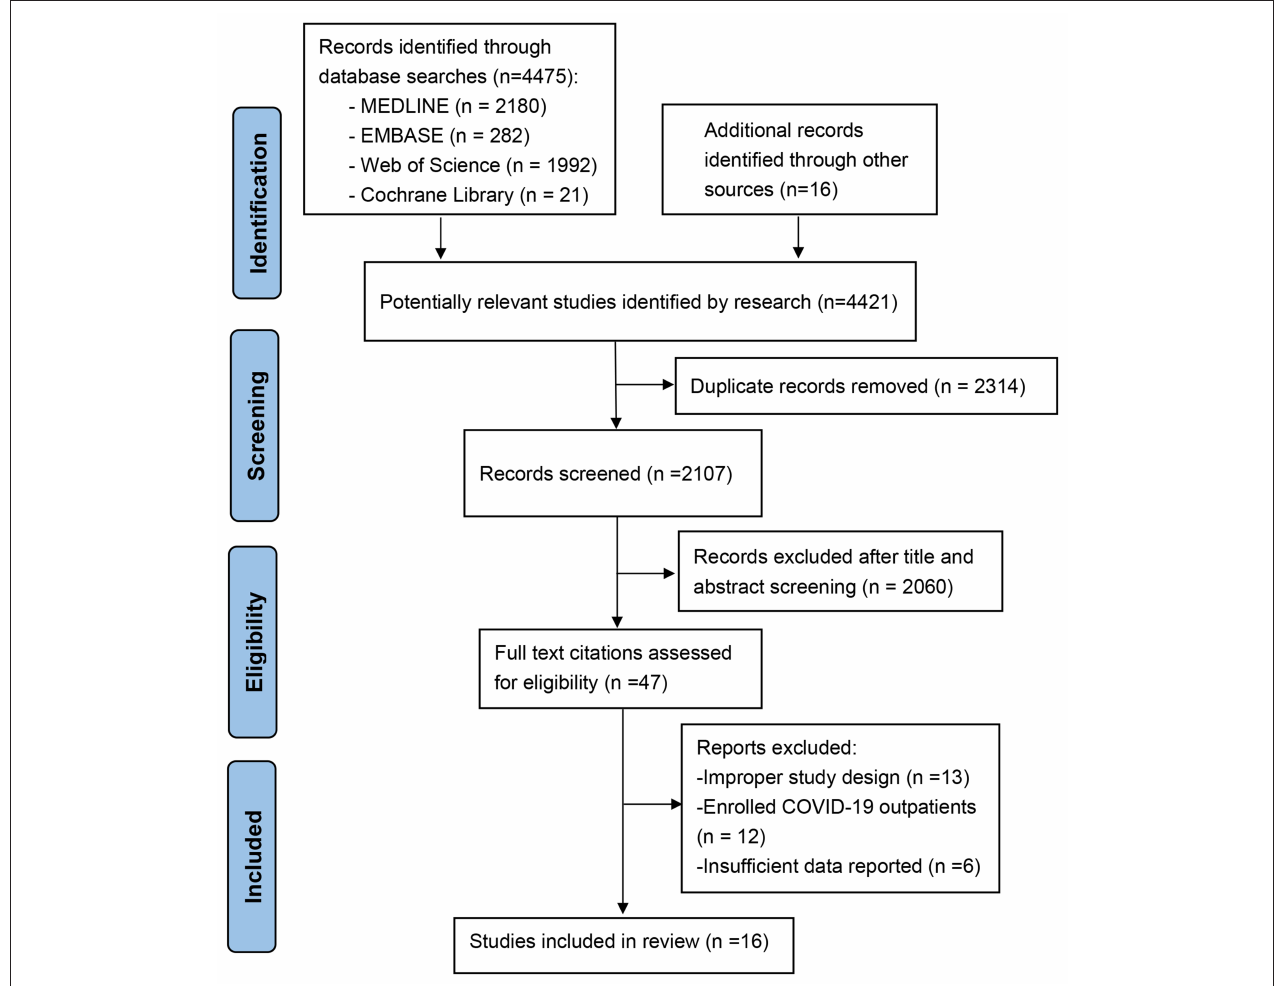
FIGURE 1 | Flowchart of selection of